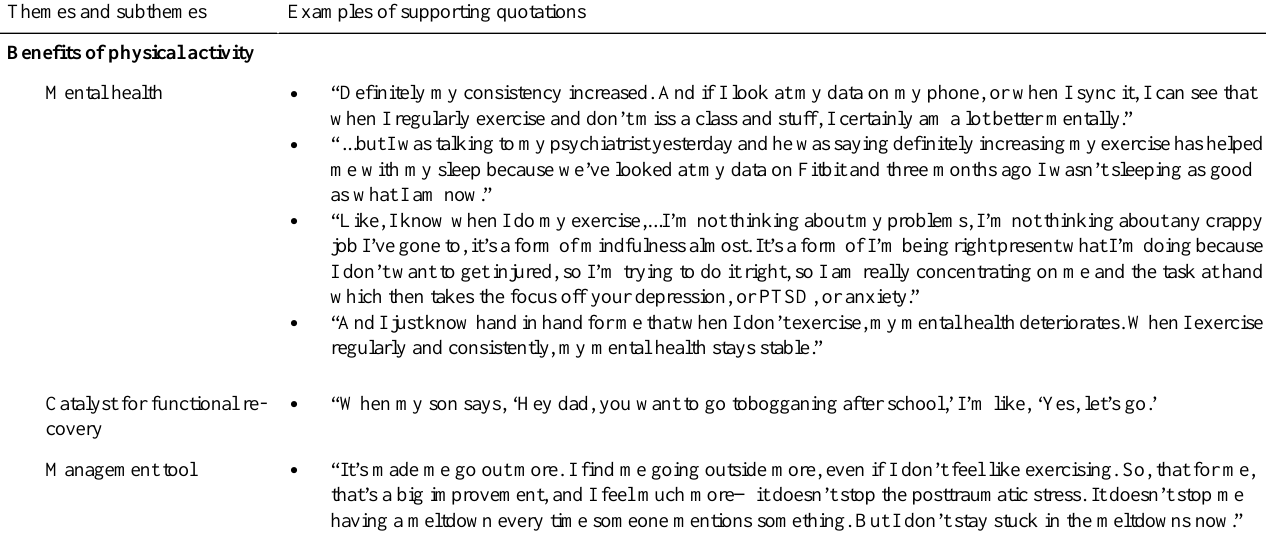
Table 4. Participant quotes from the qualitative interviews.